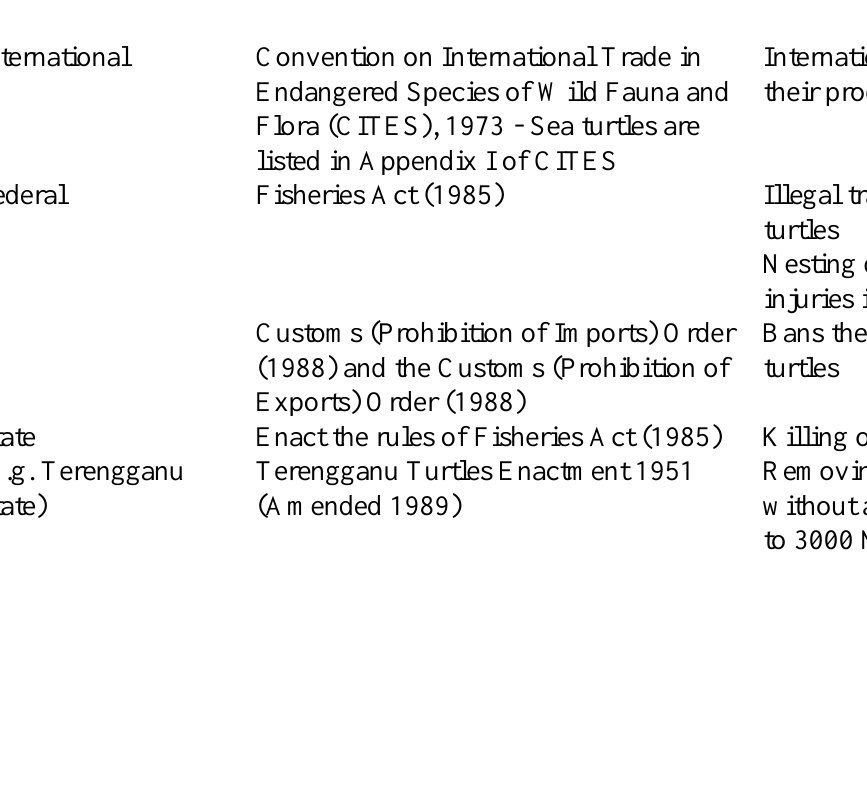
Table A1.1: In Malaysia, sea turtle related legislation operates under the international, federal and state levels. (Own synthesis based on Tan 2004, TRAFFIC Southeast Asia 2009, Zulkifli and Sankar 2011, Abd Mutalib et al.